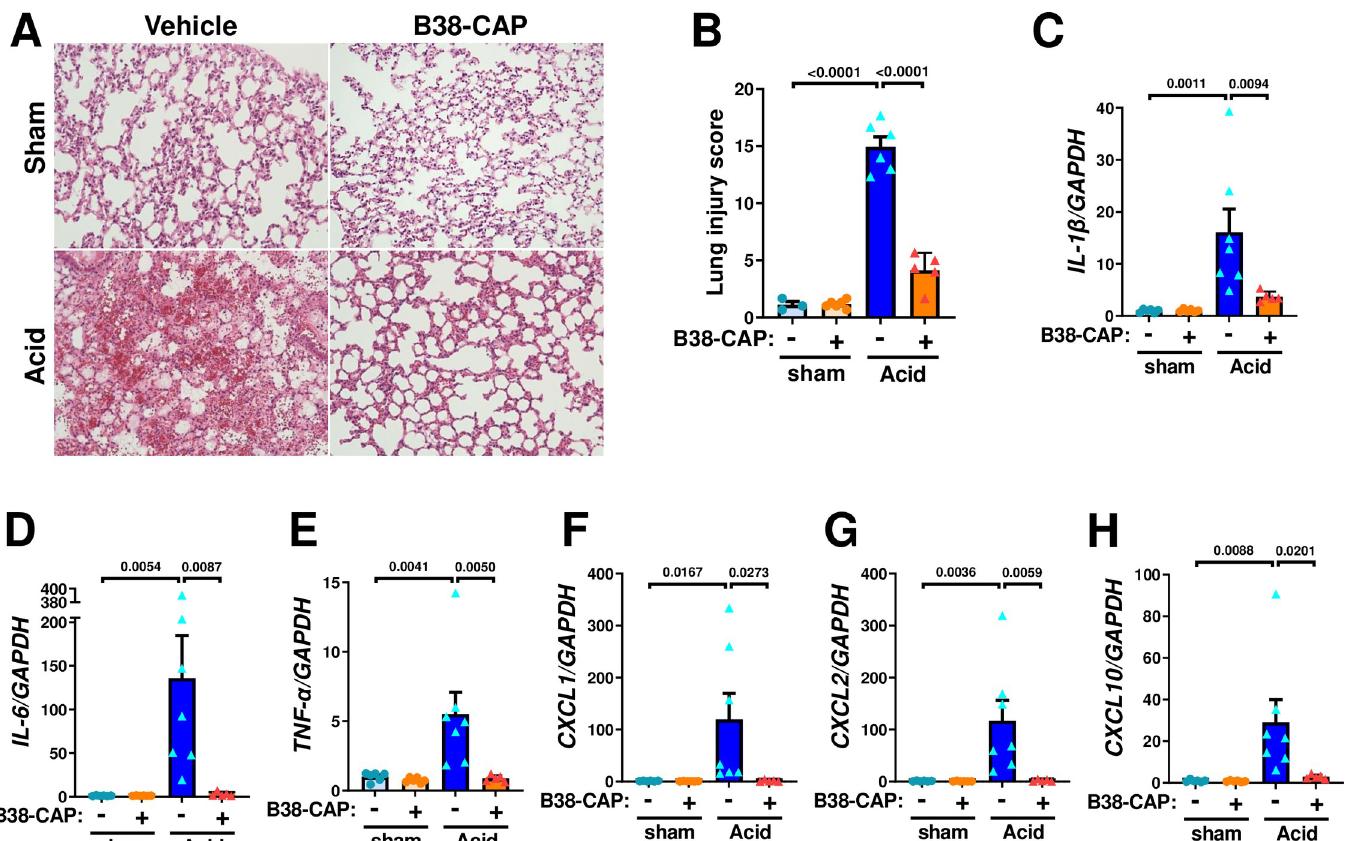
Fig 6. B38-CAP ameliorates acid instillation-induced lung inflammatory and cytokine storm. A-B , Lung histopathology. Tissue samples were harvested at 24 hours after acid instillation. Representative images are shown ( A ). Bars indicate 100 μ m. Lung injury score measurements ( B ) in the lungs of mice treated with sham + vehicle (n = 3), sham + B38- CAP (n = 6), Acid + vehicle (n = 6), and Acid + B38-CAP (n = 5). C-H , qRT-PCR analysis of pro-inflammatory cytokine expression in the lungs of mice; mRNA levels of IL-1 β ( C ), IL-6 ( D ), TNF- α ( E ), CXCL1 ( F ), CXCL2 ( G ) and CXCL10 ( H ) normalized with GAPDH. sham + vehicle (n = 6), sham + B38- CAP (n = 6), Acid + vehicle (n = 7), and Acid + B38-CAP (n = 5). All values are means ± SEM. One-way ANOVA with Sidak’s multiple-comparisons test. Numbers above square brackets show significant